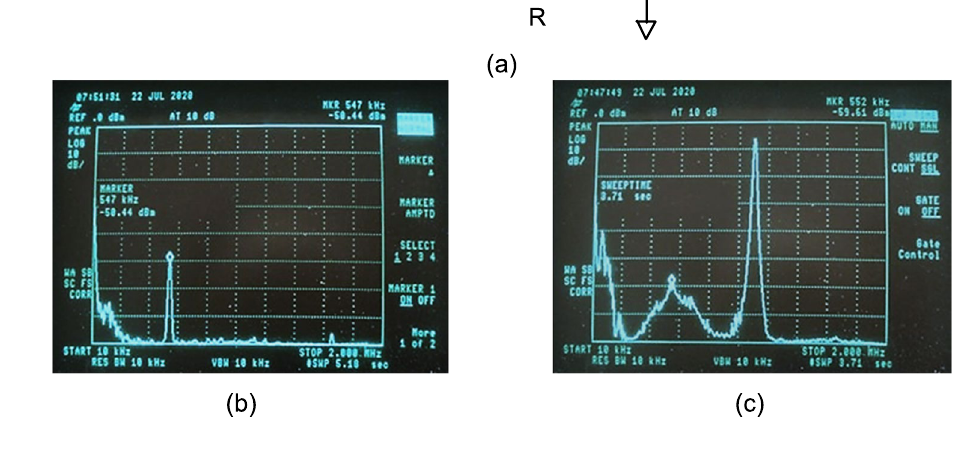
Fig. 11 a The circuit layout. b The signal: −50.44 dBm at 547 kHz. c No-signal: the ~ −60 dBm amplifier noise just below the onset of oscilla- tions. d The amplified signal at pump—1 dB below the onset of oscillation and e oscillations at pump voltage of 20 V L ted oscillations are above the transmitted